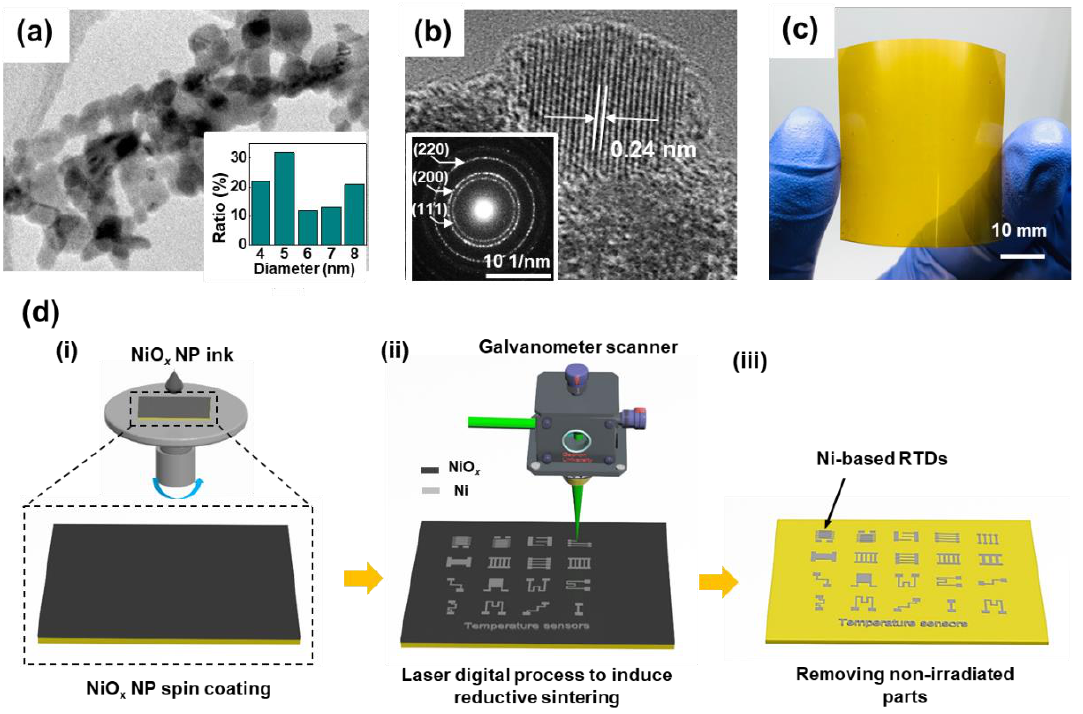
Figure 2. ( a ) Transmission electron microscopy (TEM) image of NiO x nanoparticles (NPs). The inset shows the size distribution of the synthesized NiO x NPs. ( b ) High-resolution TEM (HR-TEM) image of NiO x NPs. The inset is the selected-area electron diffraction (SAED) pattern for NiO x NPs. ( c ) A uniform NiO x NP thin film on a polyimide (PI) substrate. ( d ) Schematic diagram of the entire processes to produce Ni-based resistance temperature detectors (RTDs). ( i ) Spin-coating NiO x thin film on a polyimide substrate, ( ii ) laser digital process to fabricate Ni-based RTDs. ( iii ) Removing non-irradiated parts by the washing process.